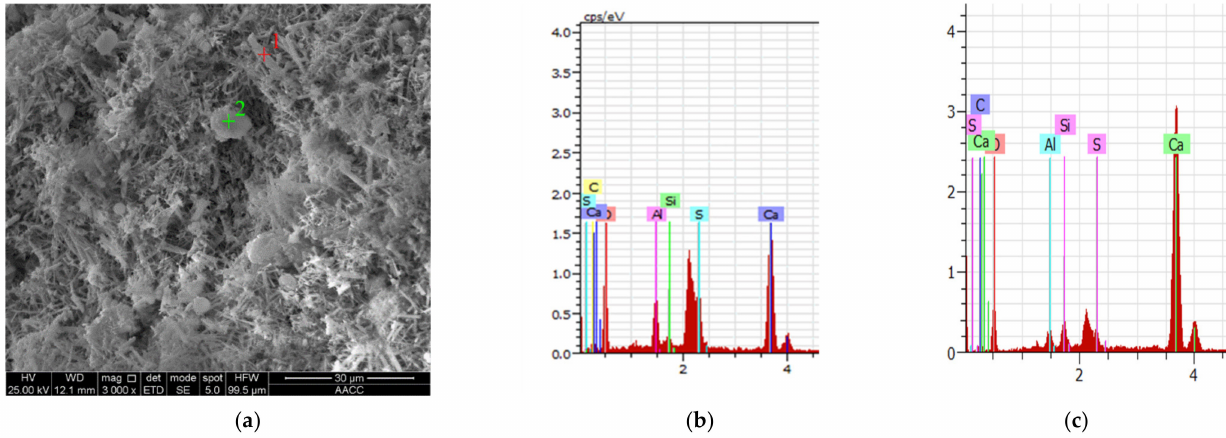
Figure 8. SEM and EDS images of the high water grouting material with W2L1-28d (MAG:3000 × ). ( a ) SEM, ( b ) EDS of Point 1, ( c ) EDS of Point